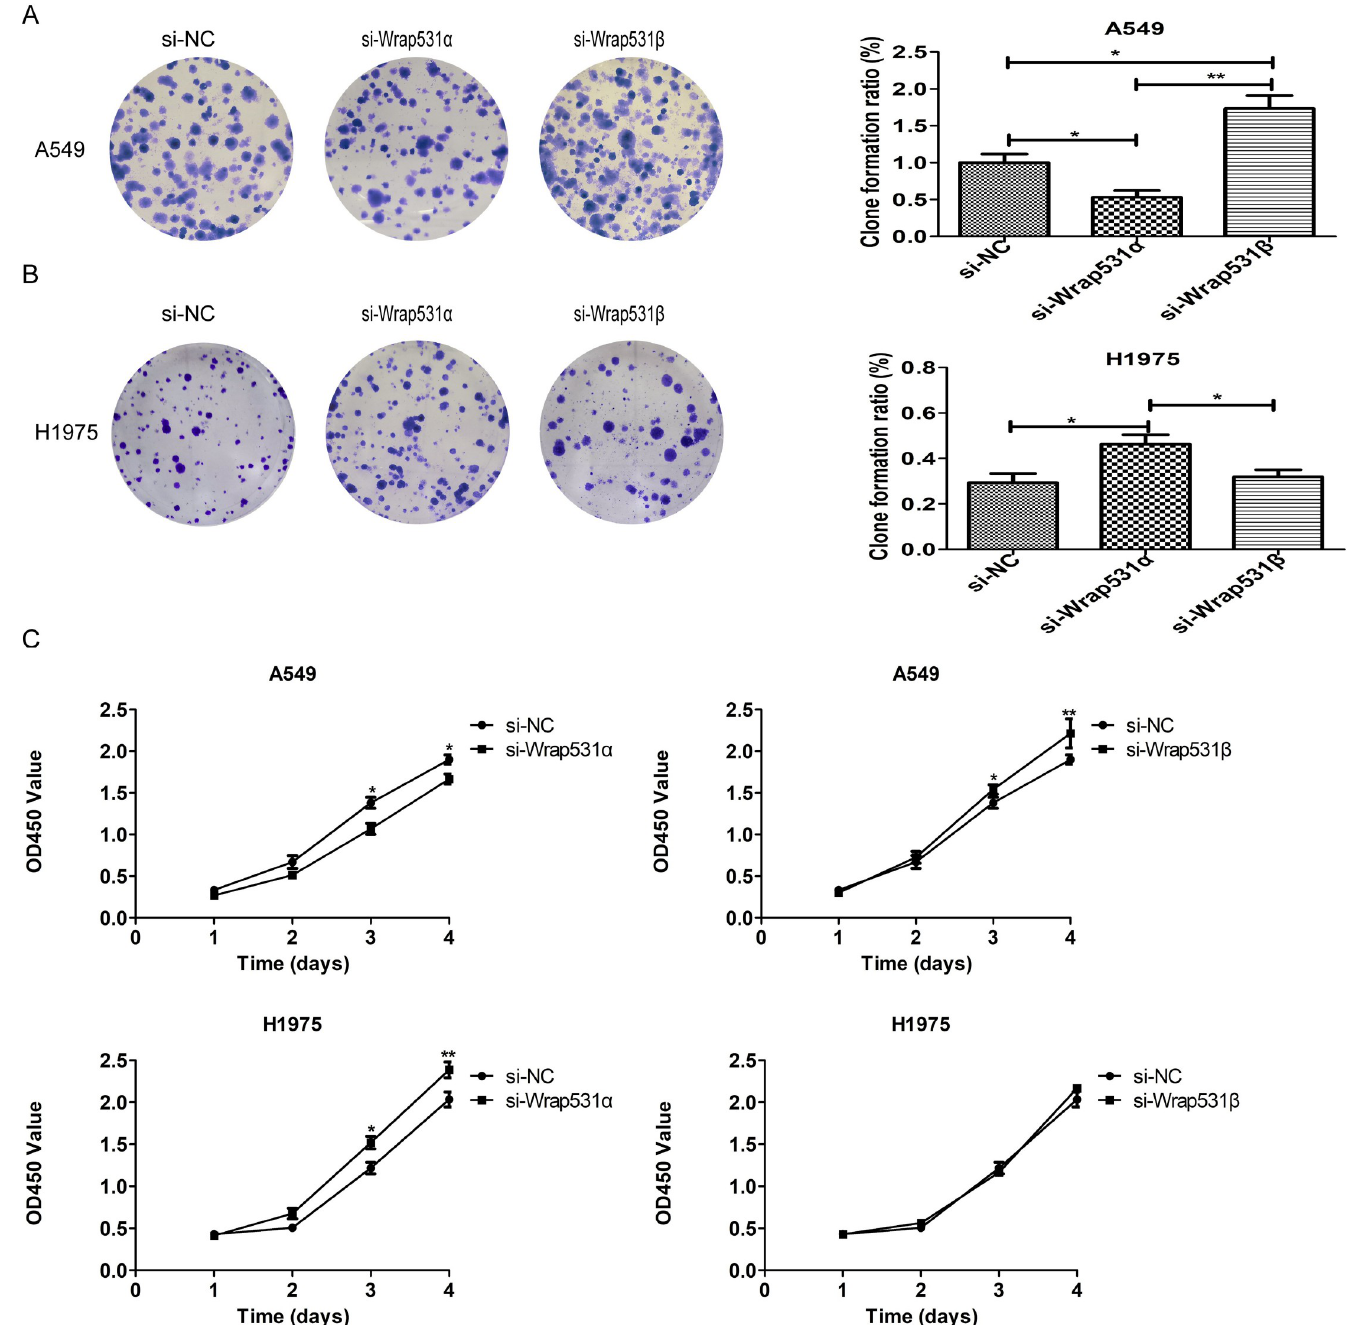
Fig 2. WRAP53 - 1 α and WRAP53-1 β have different effects on NSCLC cell proliferation. (A) Representative images of colony formation assays using A549 cells transfected with WRAP53 or control siRNA. Knockdown of WRAP53 -1 α reduced colony formation, whereas knockdown of WRAP53-1 β had the opposite effects. (B) Knockdown of WRAP53 -1 α increased colony formation in H1975 cells. (C) Proliferation of cells transfected with si-WRAP53-1 α or si-WRAP53-1 β was measured by CCK-8 assay. Knockdown of WRAP53 - 1 α reduced A549 cell proliferation, whereas knockdown of WRAP53-1 β increased proliferation. In H1975 cells, depletion of WRAP53 - 1 α increased proliferation, and depletion of WRAP53-1 β had no effect. N = 3; � , P < 0.05; �� , P < 0.01.